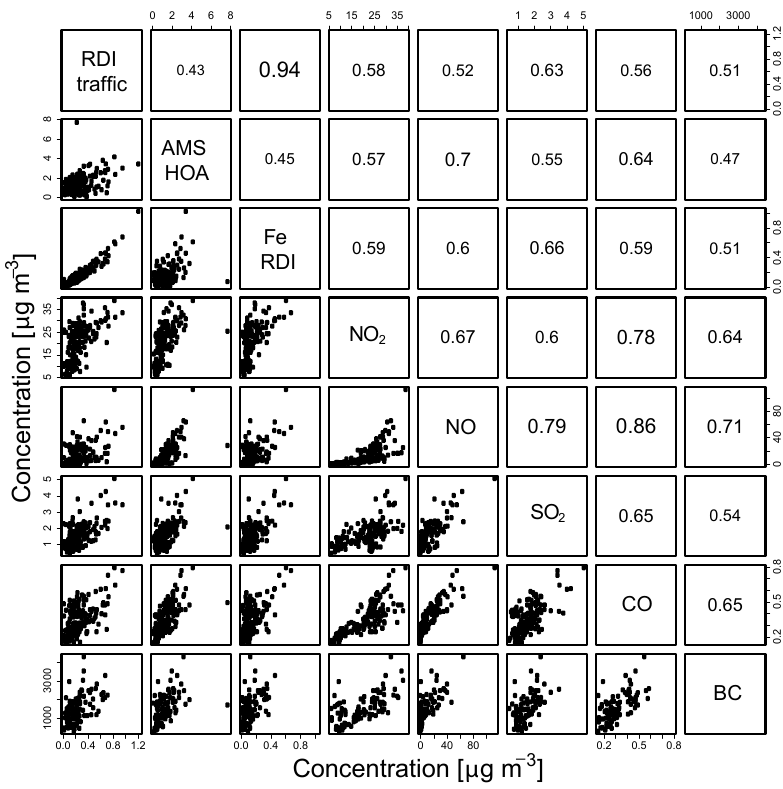
Fig. 11. Matrix of scatter plots showing the pair-wise correlations of the traffic factor found for PM 10 − 2 . 5 (must abundant in this size range) with RDI-PMF, the AMS-HOA factor, Fe (also PM 10 − 2 . 5 ) measured with RDI, NO 2 , NO, SO 2 , CO and BC PM 1 mass concentrations (shown are only most relevant species, the ones not shown do not have significant correlation). The panels in the upper right half show the Pearson correlation coefficients and the lower left panels show corresponding data